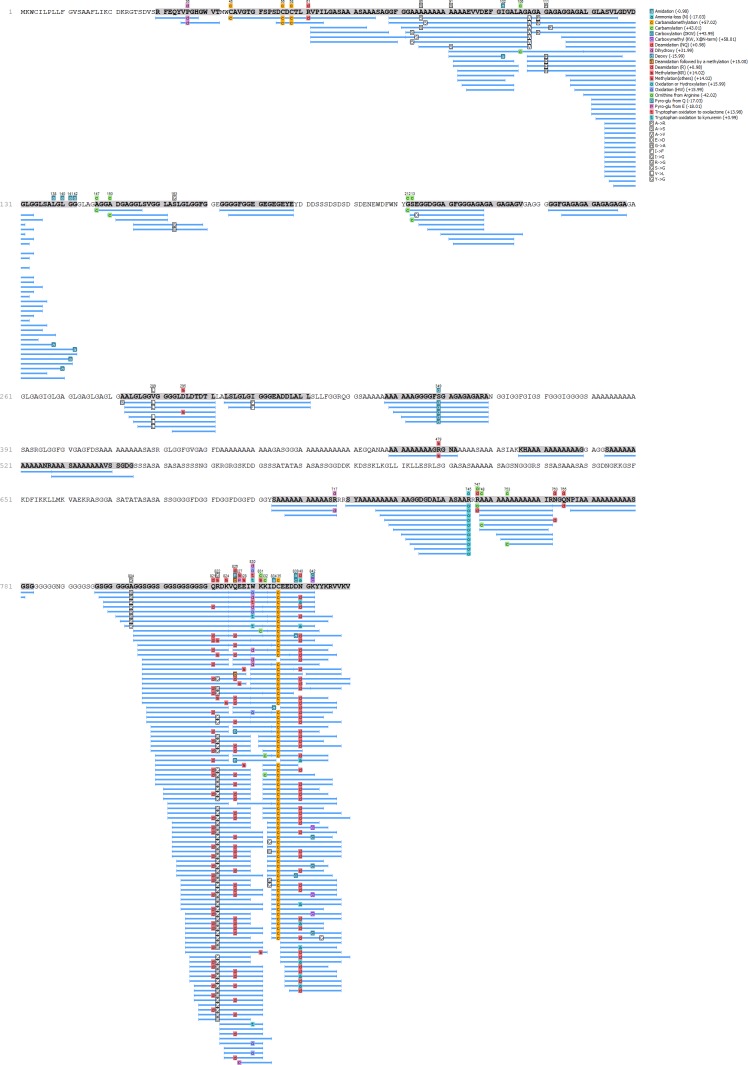
HavC - Hic74 coverage.